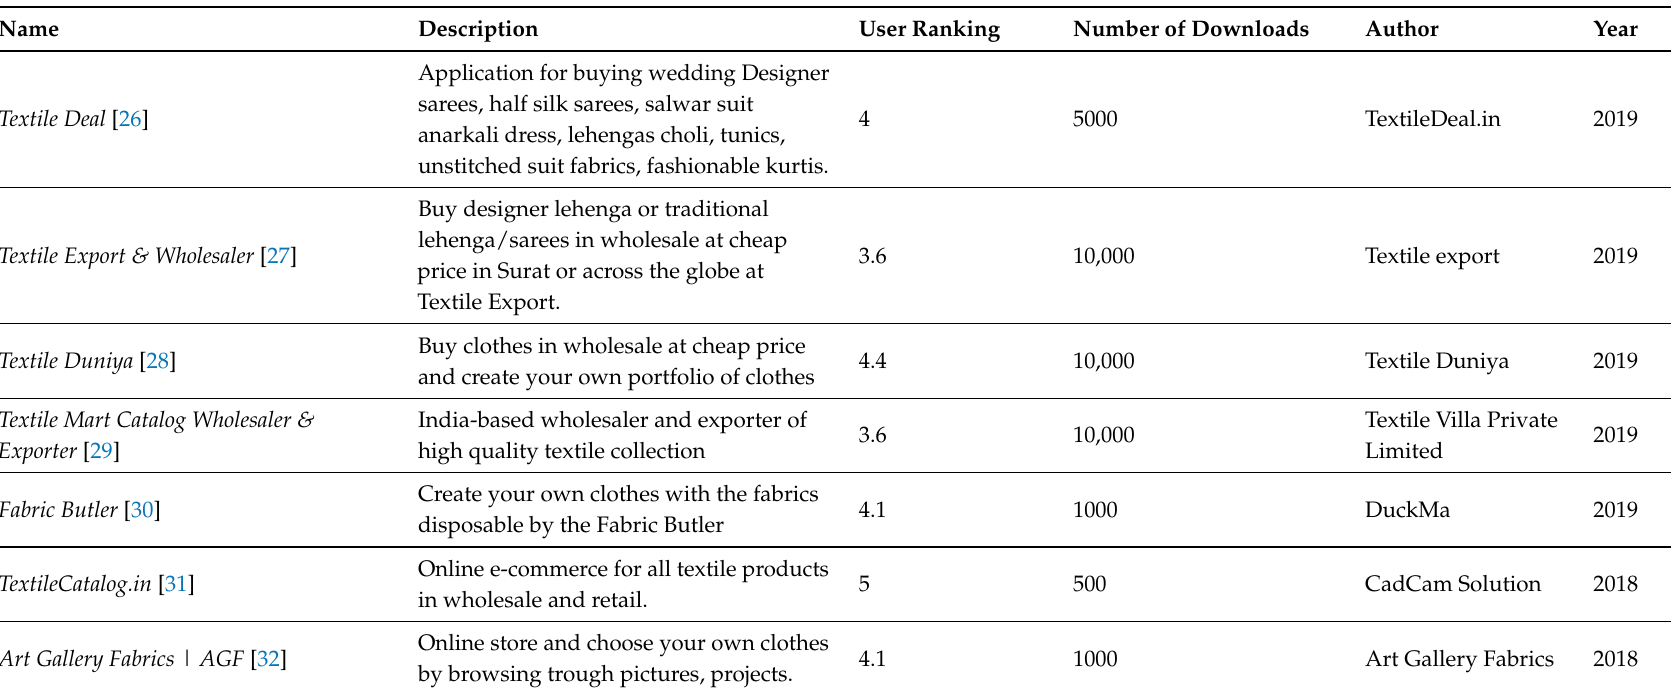
Table 1. List of mobile applications